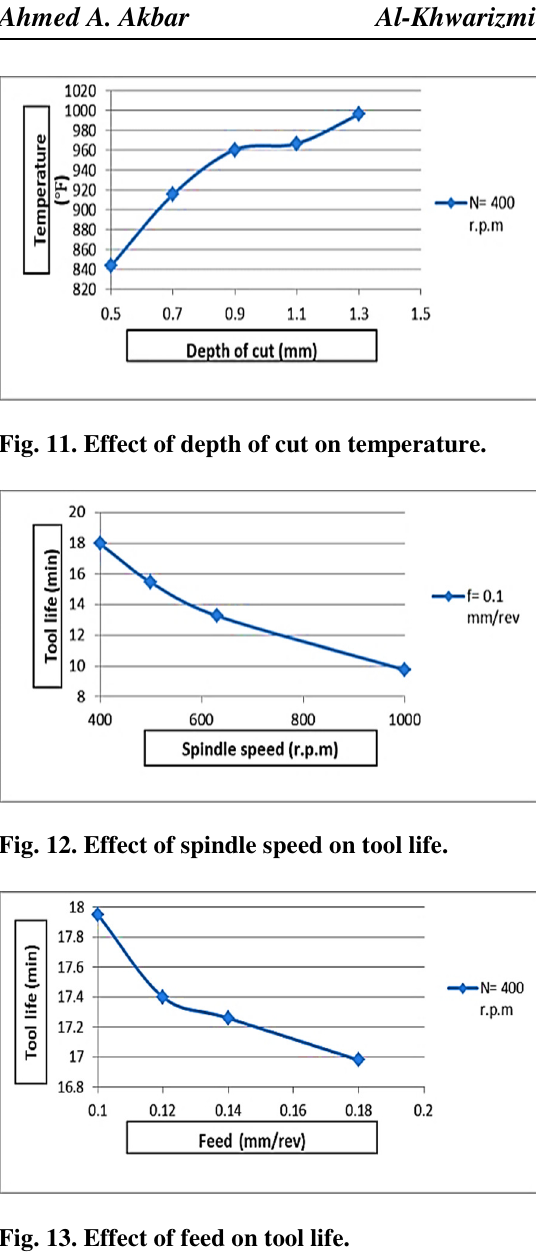
Fig. 13. Effect of feed on tool life.